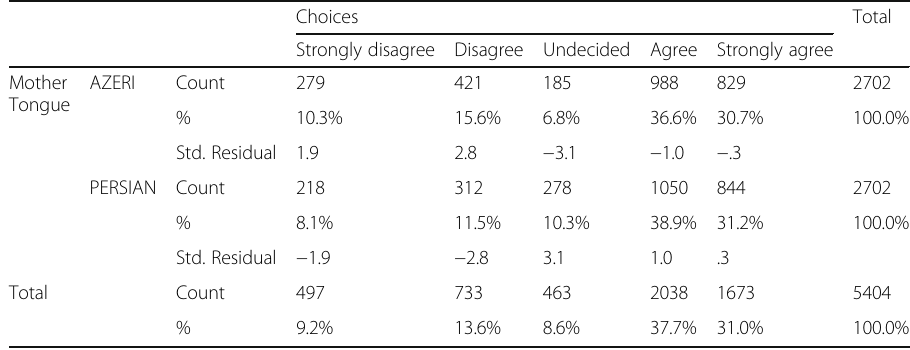
Table 2 Frequencies, percentages and standardized residuals of the perceptions towards explicit grammar instruction and corrective feedback Choices Total Strongly disagree Disagree Undecided Agree Strongly agree Mother Tongue